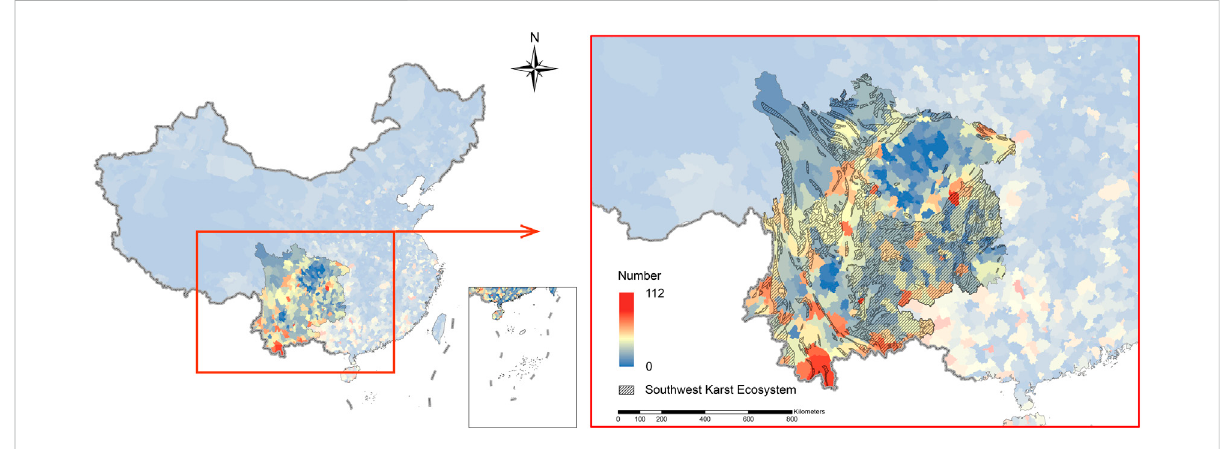
FIGURE 1 Richness of the typical invasive alien species among karst systems in southwest China. Blue represents counties with low richness, red represents counties with high richness. Crosshatch regions mean karst systems in southwest